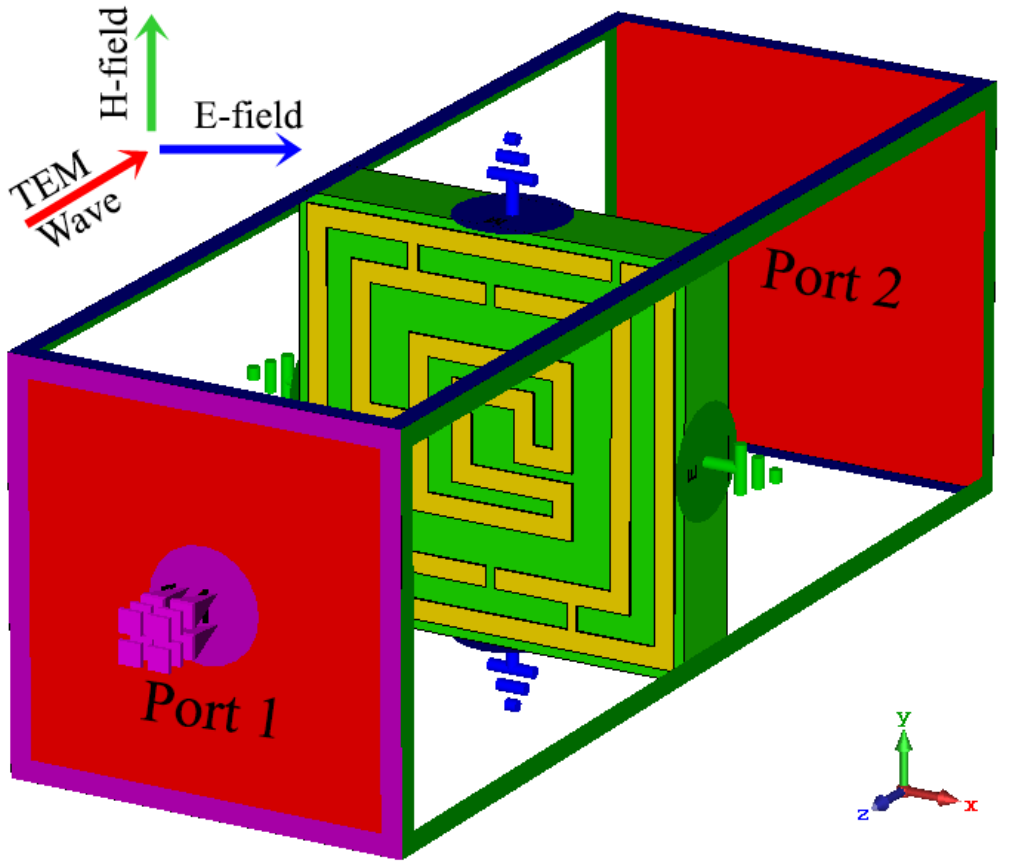
Figure 5. Simulation setup of metamaterial unit cell in computer simulation technology (CST). Table 2. Proposed unit cell parameters